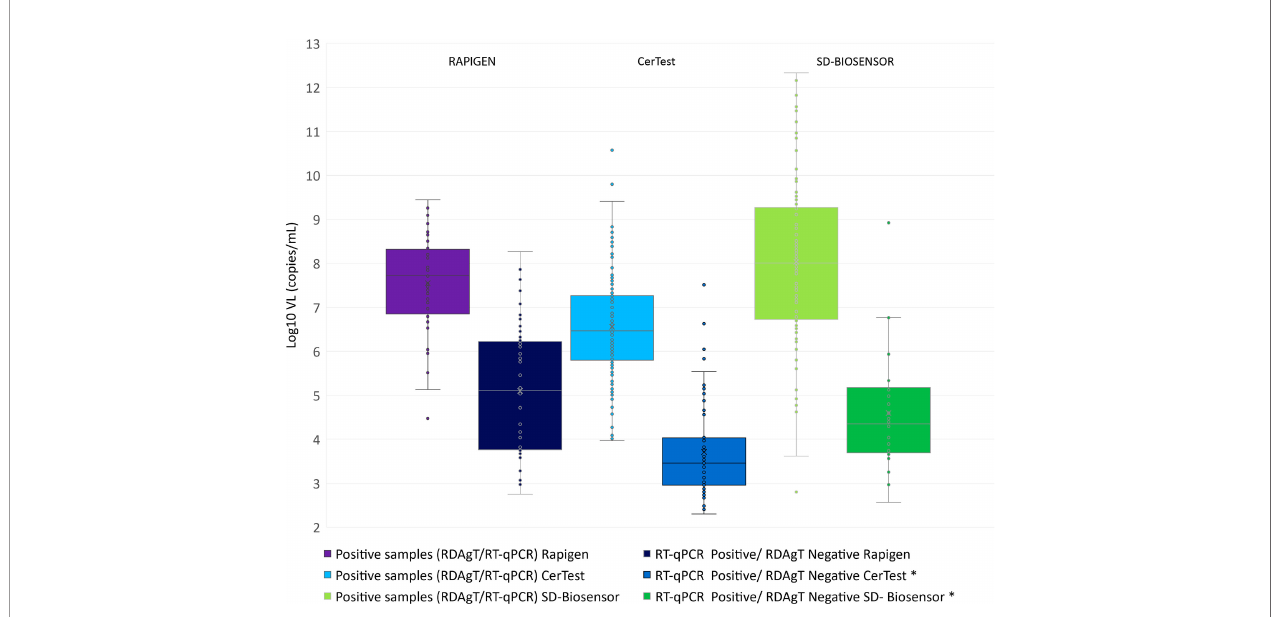
FIGURE 1 | Viral loads distribution for all the SARS-CoV-2 positive samples by RT-qPCR was included in the study. Viral loads (VL) are presented on a Log10 scale. The different sets of samples used for each Rapid Diagnosis Antigen Test (RDAgT) brand are divided into two categories: RDAgT positive and RDAgT negative. *There are statistically signi fi cant differences (p < 0.05) for VL between RDAgT positive and RDAgT negative only for Certest Biotec and SD-Biosensor